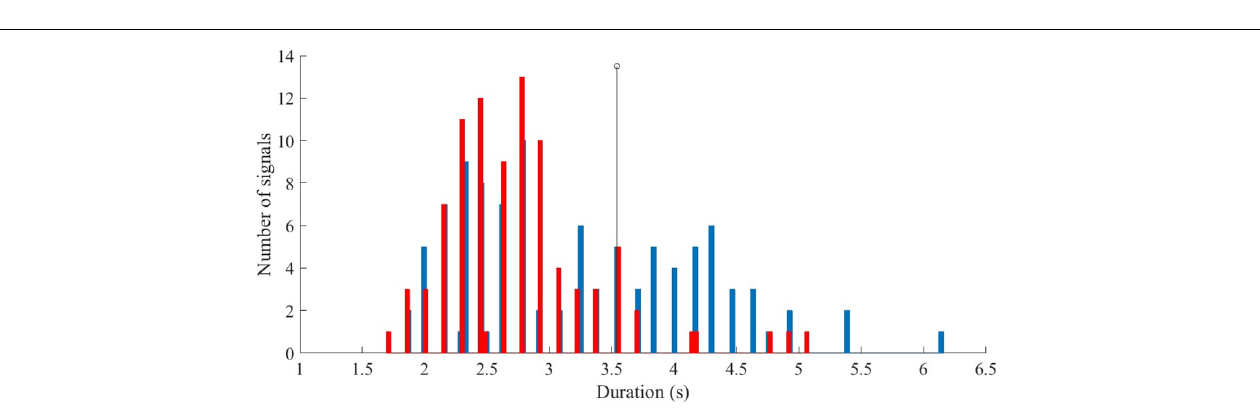
FIGURE 6 | Boxplots showing the first quartile, median, third quartile of the call duration of Bryde’s whale data from the north (Bahía de Los Ángeles, Baja California) from November 2006 to June 2007 and the south (Punta Pescadero, Baja California Sur) from August to December 2008. The calls of both sites are significantly different ( p = 0.003). Outliers are represented as (+).